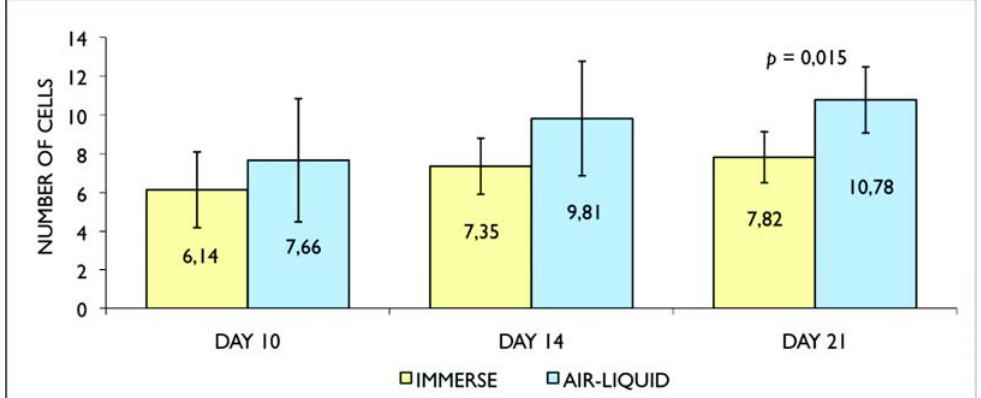
FIGURE 5 - Significant difference ( p =0.015) between immerse and air-liquid interface cultures at day 21, but not at day 10 ( p =0.388) and day 14 ( p